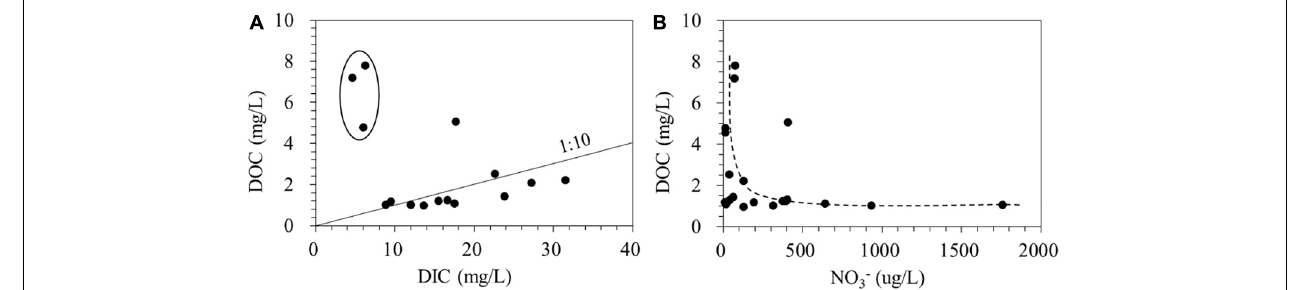
FIGURE 9 | Schematic of the processes of submarine groundwater discharge (SGD) and riverine nitrate and carbon to the ocean on (A) near shore scale with shallow water, and (B) shelf scale with deep water.